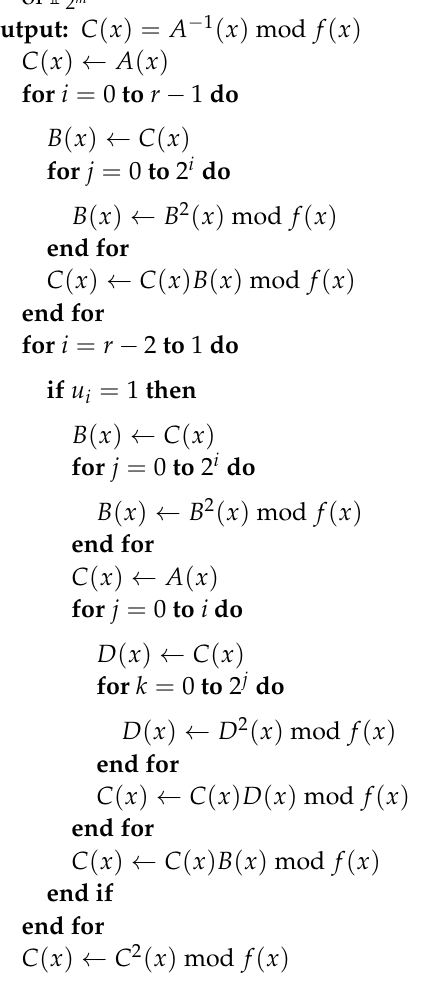
Algorithm 4 Itoh-Tsujii Inversion for Generic Binary Fields Where Additional Cycles are